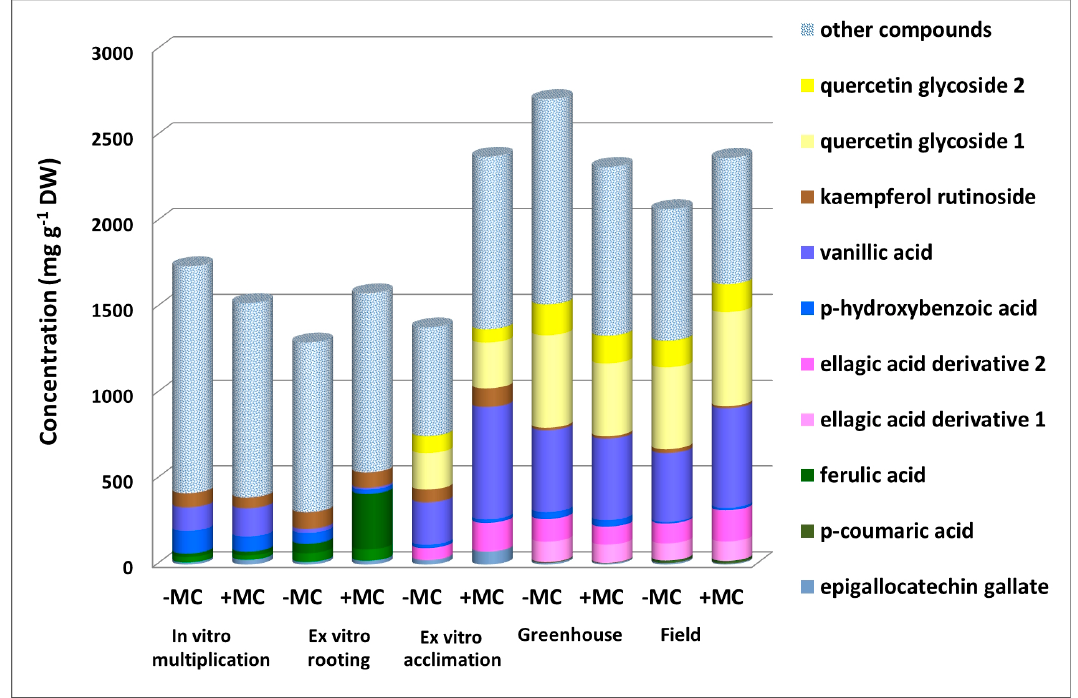
Figure 5. Phenolic compounds with the greatest concentration shift during development under in vitro, ex vitro, and in vivo conditions under the influence of the MC treatment. MC, mechanocom-